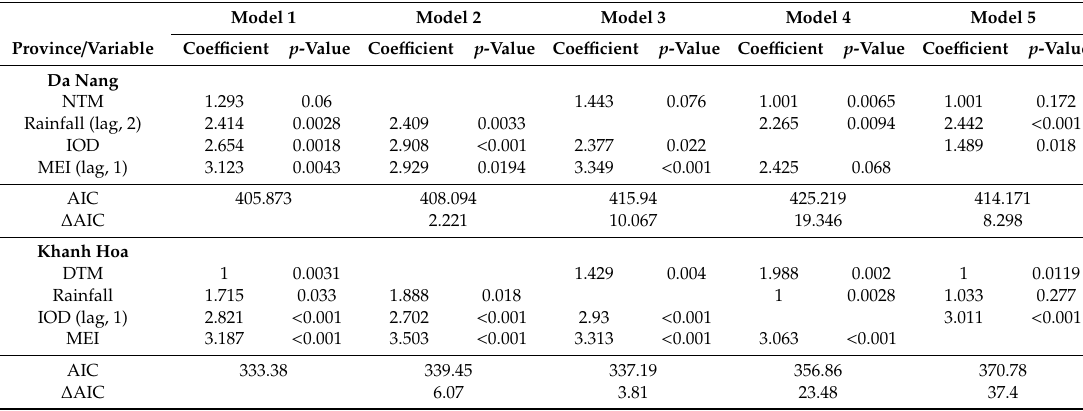
Table 2. Generalized additive model (GAM) models of climate variables and dengue incidence in Da Nang and Khanh Hoa Model 1 Model 2